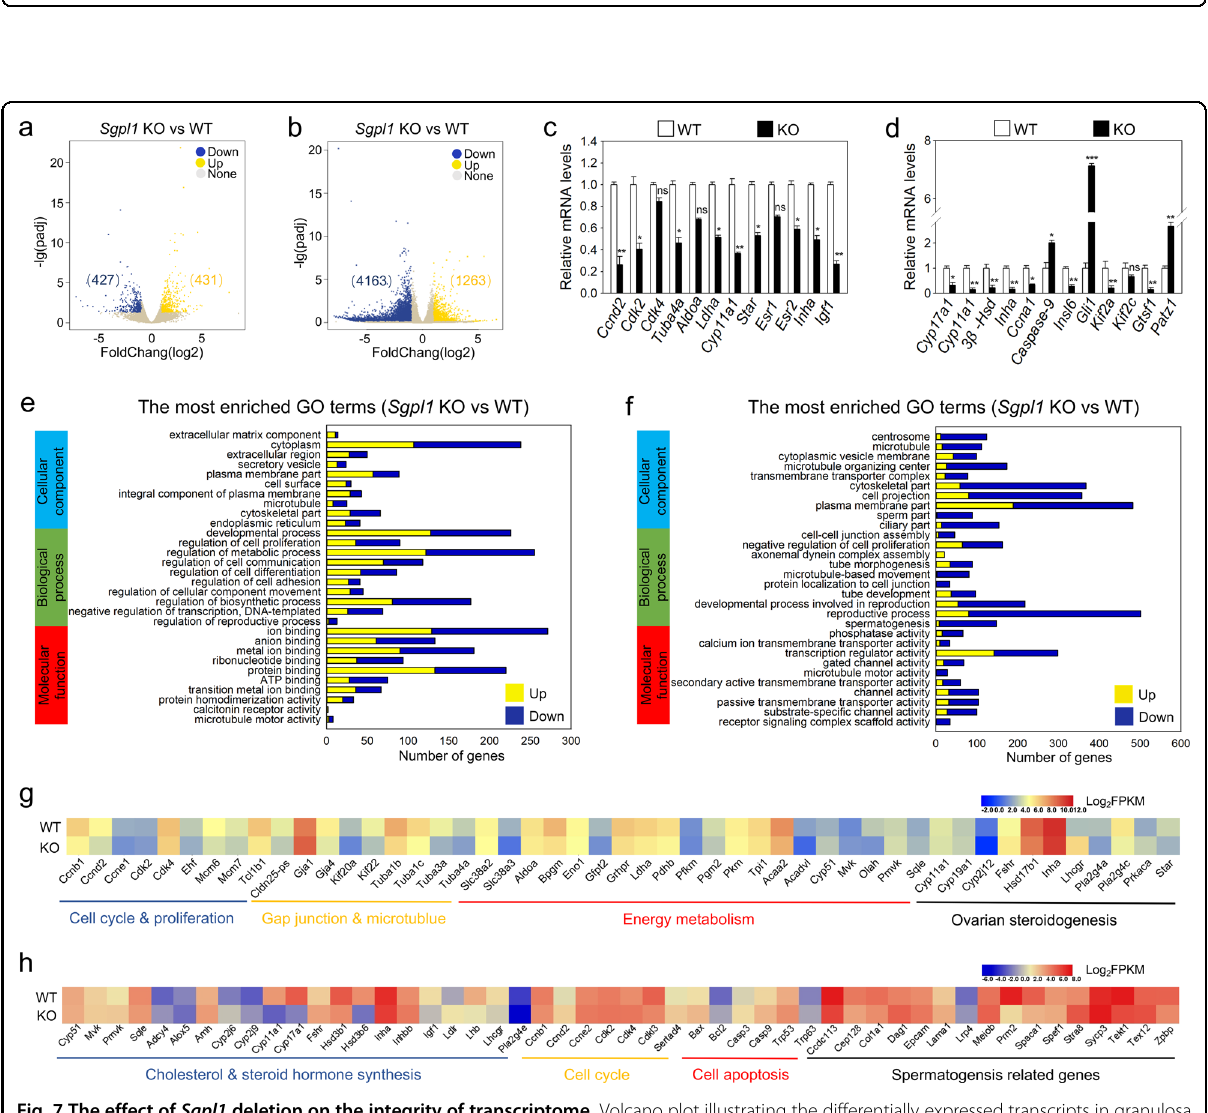
Fig. 7 The effect of Sgpl1 deletion on the integrity of transcriptome. Volcano plot illustrating the differentially expressed transcripts in granulosa cells ( a ) and testes ( b ). Down downregulated in KO mice compared with WT mice, Up upregulated in KO mice compared with WT mice, None no differences in KO mice compared with WT mice. c , d The changes in the expression of representative transcripts selected from the RNA-seq data were validated by qRT-PCR. ( n = 4 independent experiments). Bars indicate the mean ± SEM. ns no signi fi cance, * p < 0.05, ** p < 0.01 and *** p < 0.001 vs. the WT group. GO analysis of the differentially expressed genes in granulosa cells ( e ) and testes ( f ). g Heat map illustrating differences between WT and KO granulosa cells in the expression of a group of transcripts involved in various processes. h Heat map illustrating differences between WT and KO testes in the expression of a group of transcripts involved in various